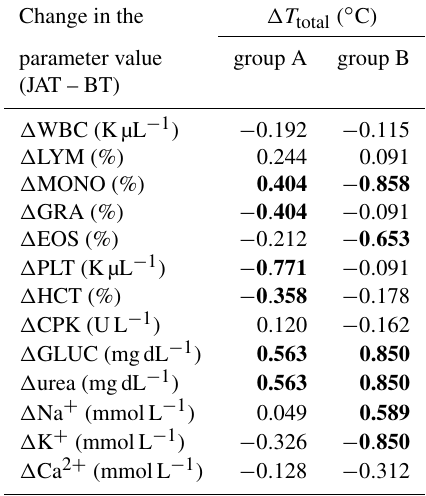
Table 4. Values of Spearman’s rank correlation coefficients ( ρ ) be- tween the changes in body surface temperature ( (cid:49)T ) and blood pa- rameters in the horses from two